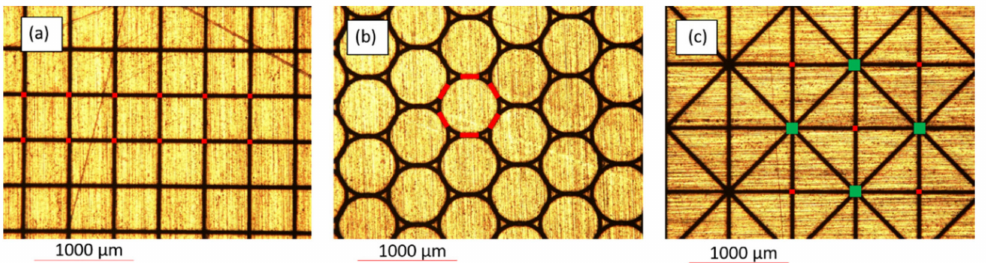
Figure 4. Microscopic images of the three textured geometries: ( a ) square lattice; ( b ) hexagonal-circle lattice; ( c ) triangular lattice. TS = 20%. In red and green are the overlapping areas of two and four laser lines,